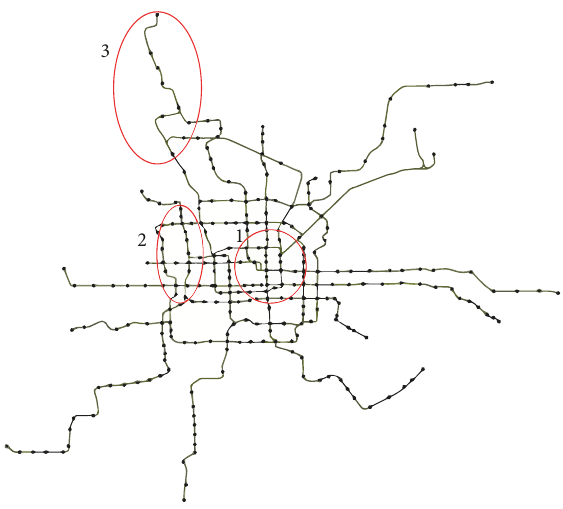
Figure 2: The selected stations in three areas of Beijing.